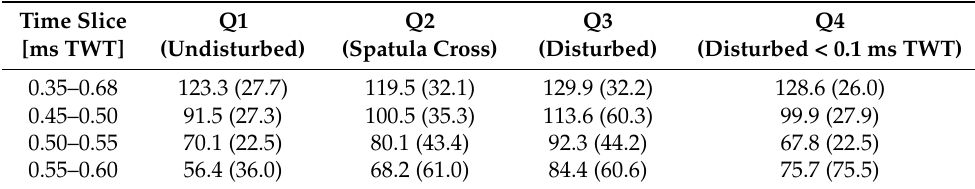
Table 1. Mean of RMS amplitude (standard deviation) in all quadrants (Q1–4) of RMS amplitude time slices (Figure 4e–h).